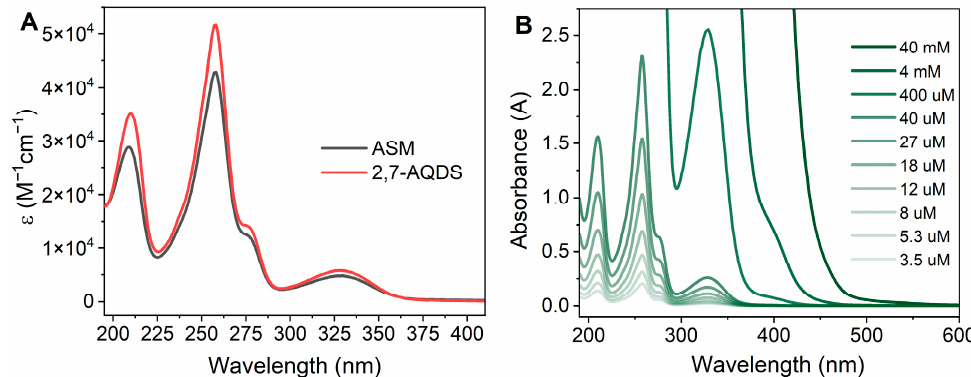
Figure 2. ( A ) Molar extinction coefficients of 2,7-AQDS and ASM ( B ) Optical and near-UV absorption spectra of 2,7-AQDS diluted by deionized water, optical path length—1 cm.